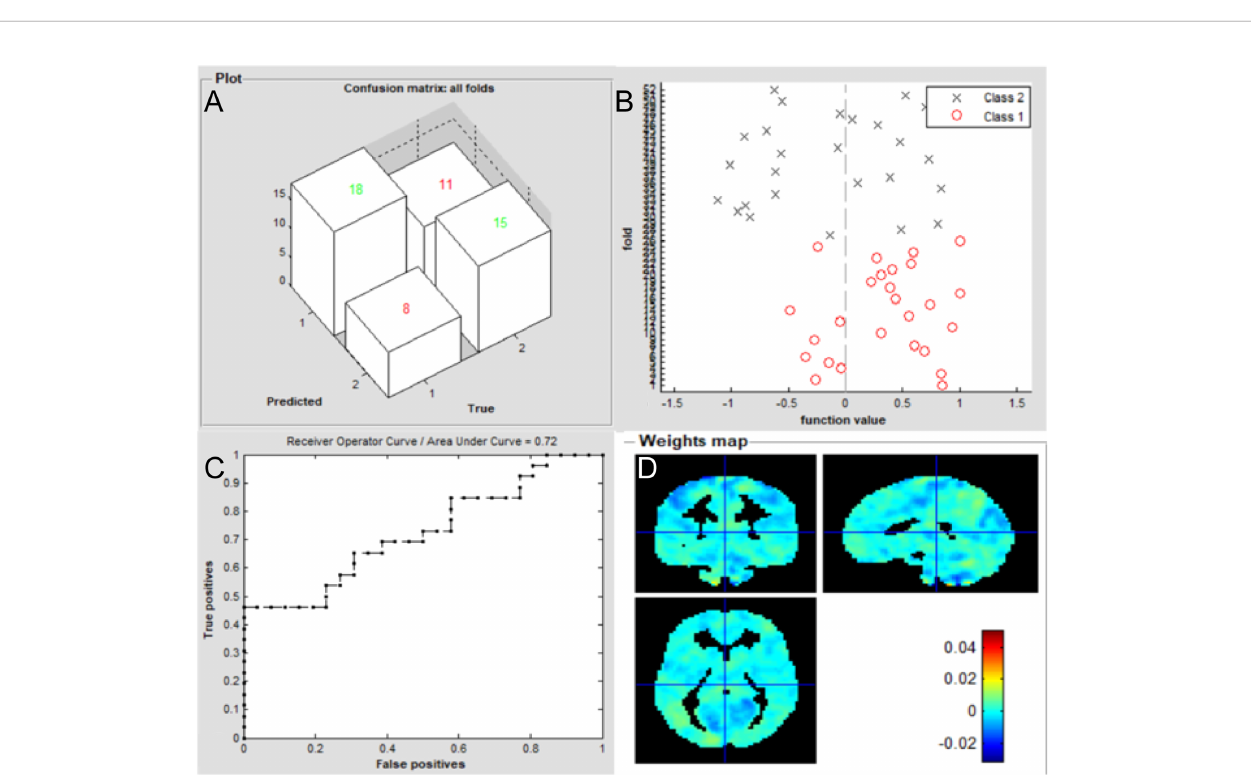
FIGURE 6 | Classi fi cation results using machine learning analysis based on FC of the left V1. (A) three-dimensional confusion matrices from machine learning analysis; (B) function values of two groups (class 1: patient group; class 2: HC group); (C) The ROC curve of the classi fi er, and the AUC was 0.72; (D) Weight maps for SVM models. The weight in each voxel corresponding to its contribution to the model ’ s